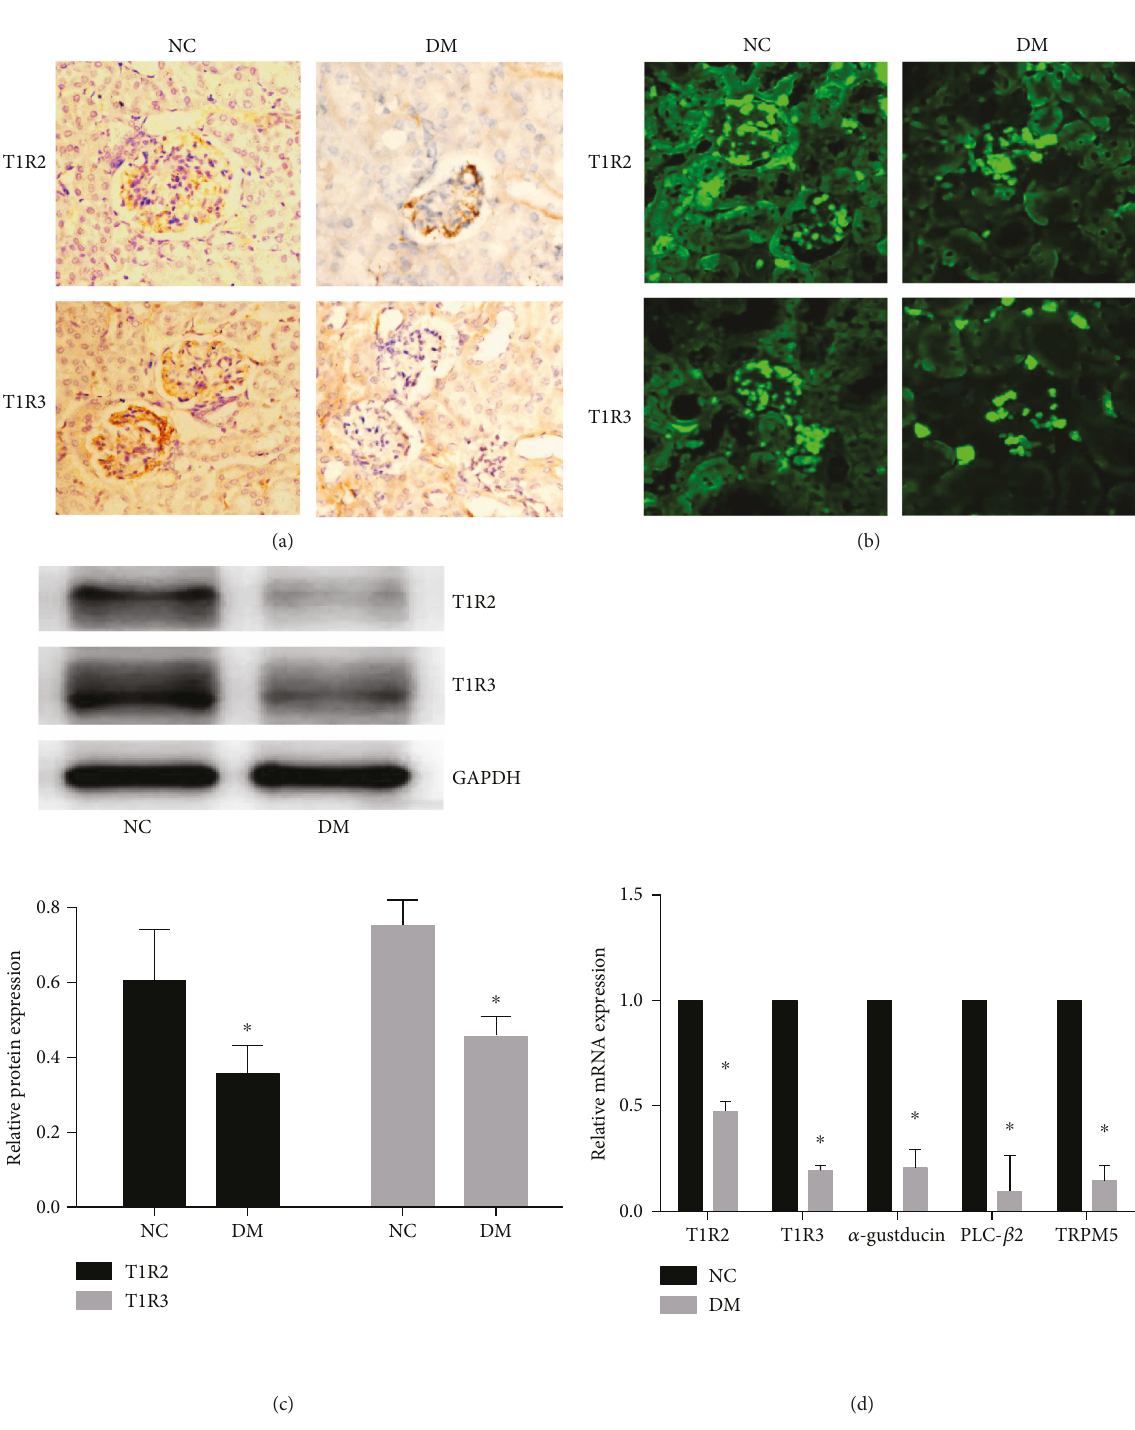
Figure 2: The expression of STRs and associated signaling components was downregulated in renal tissue of DM mouse models. Representative images of immunohistochemistry (a) and immuno fl uorescence (b) staining showed that T1R2 and T1R3 expression was downregulated in renal tissue of DM mouse models. T1R2 and T1R3 expression was represented as the positive yellow-brown stained area (immunohistochemistry, 200 × ) or green fl uorescence area (immuno fl uorescence, 200 × ). (c) STR-associated signaling component ( α -gustducin, PLC β 2, and TRPM5) mRNA expression in renal tissues was detected by qRT-PCR. Data are presented as means ± SD; the gray graph con fi rmed these trends. ∗ p < 0 05 versus NC